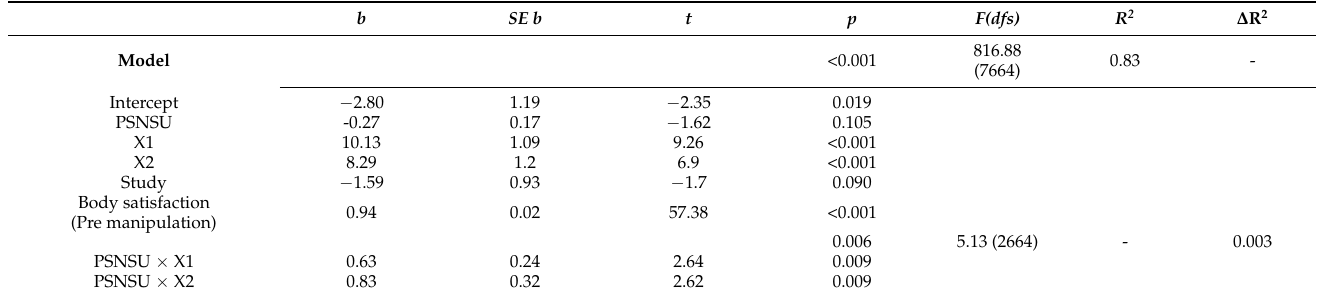
Table 5. Moderation model with Condition, PSNSU, and Their Two-Way Interactions as Predictors of Body Satisfaction (Post manipulation).